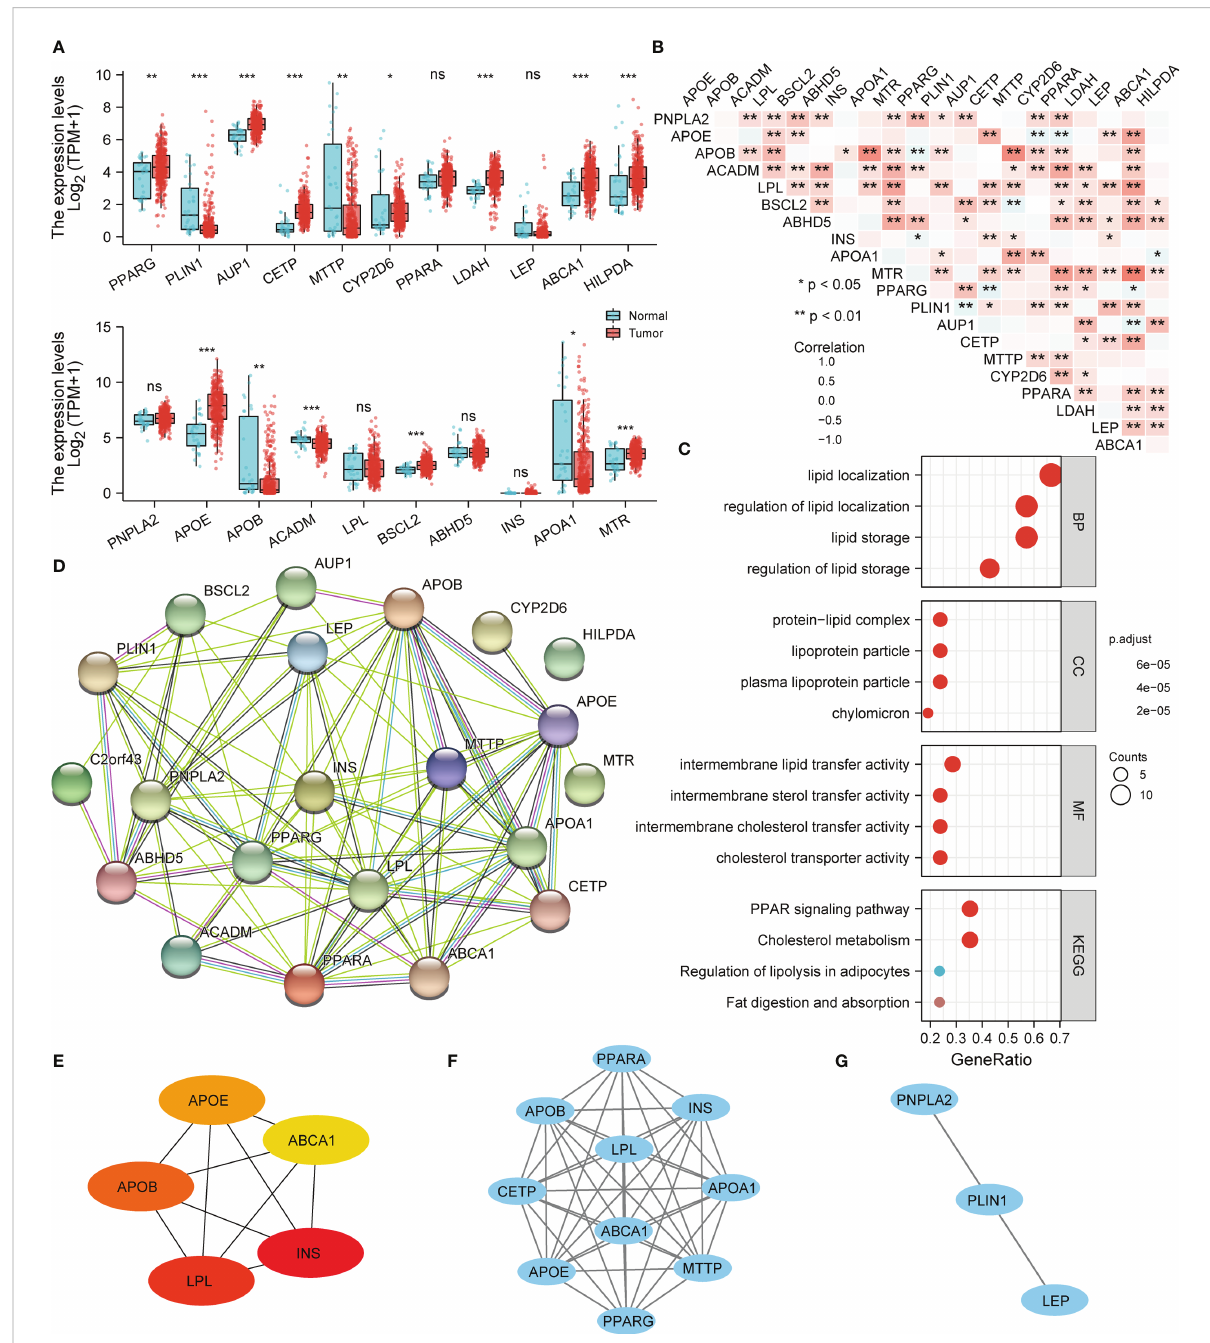
FIGURE 1 The differential expression and functional enrichment analysis of LDMRGs in STAD. (A) Differential expression analysis of LDMRGs in STAD. (B) Correlation analysis of the expression of LDMRGs in STAD. (C) GO and KEGG pathway enrichment analysis of LDMRGs. (D) Construction of PPI interaction network for LDMRGs using the STRING database. (E) Identi fi cation of the top 5 hub genes in the PPI Interaction network of LDMRGs by cytoscape software. (F, G) Identi fi cation of key network modules in PPI interaction network for LDMRGs via cytoscape software. (ns: p > 0.05, *: p ≤ 0.05, **: p ≤ 0.01, ***: p ≤